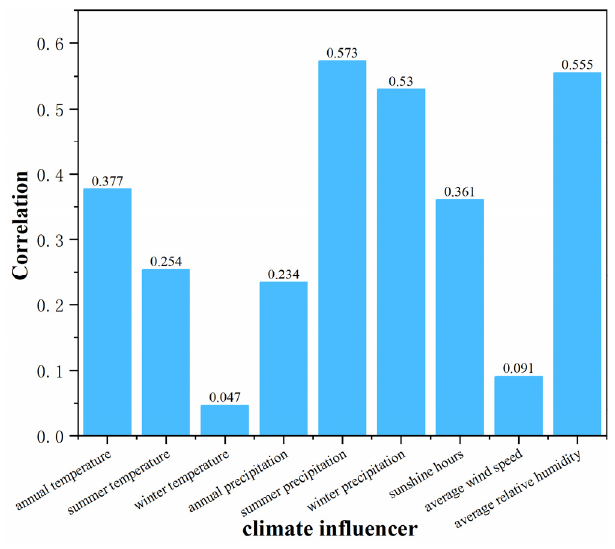
Figure 10. Correlation of climate factors.